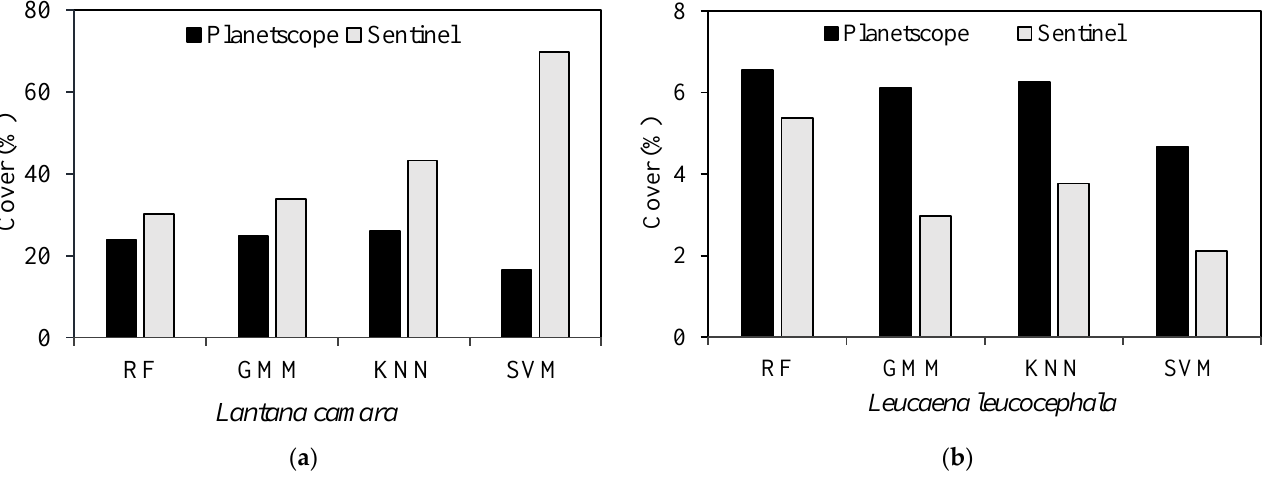
Figure 8. Graphical representation of cover percentage sof L. camara ( a ) and L. leucocephala ( b ) using all ML algorithms with PlanetScope and Sentinel-2 data.